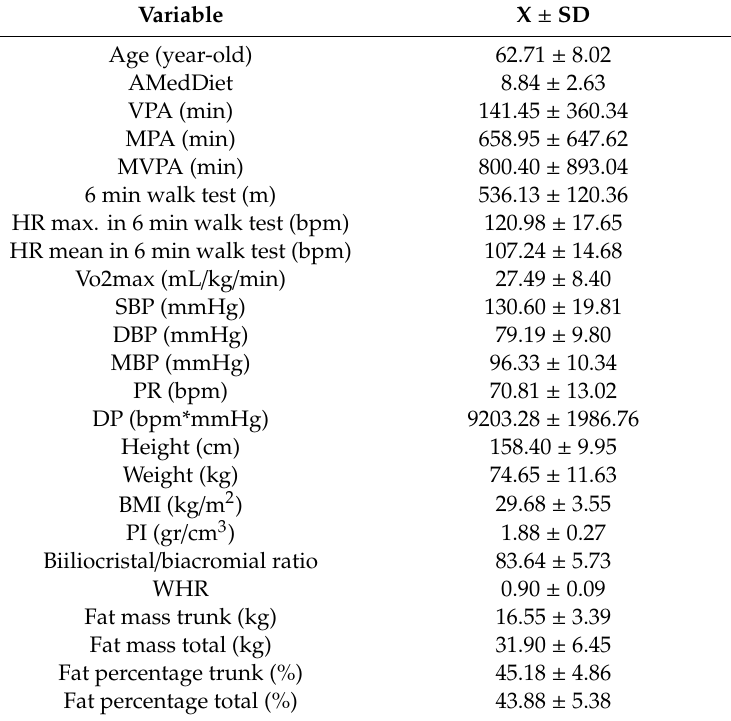
Table 1. Characteristics of the participants ( n =